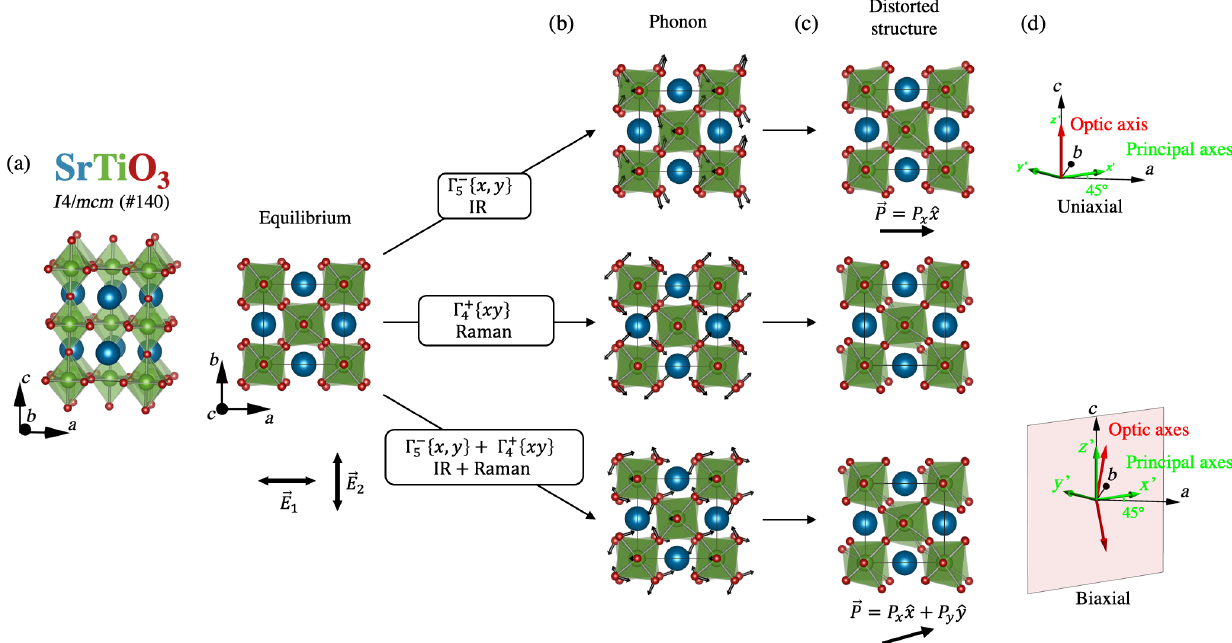
FIG. 5. Activation of IR and Raman phonons, and symmetry breaking in SrTiO 3 through IRRS. (a) Equilibrium crystal structure of SrTiO 3 from two perspectives. (b) Schematic representation of the IR, Raman, and combined IR and Raman phonons. The Γ − 5 IR phonon at 16.40 THz and the Γ þ 4 Raman phonon at 13.02 THz are shown here. (c) Distorted structure when IR, Raman, and the combined IR and Raman phonons are included. The induced polarization is canted by the activation of the Γ − 5 IR phonon polarized in the x - y plane and the Γ þ 4 Raman phonon that transforms like xy . (d) Away from equilibrium, the uniaxial nature of SrTiO 3 is altered — splitting and tilting the optical axes. Here, x 0 ; y 0 ; z 0 are the principle axes of the distorted crystal with the optical axes canted from z 0 in the z 0 - x 0 plane.